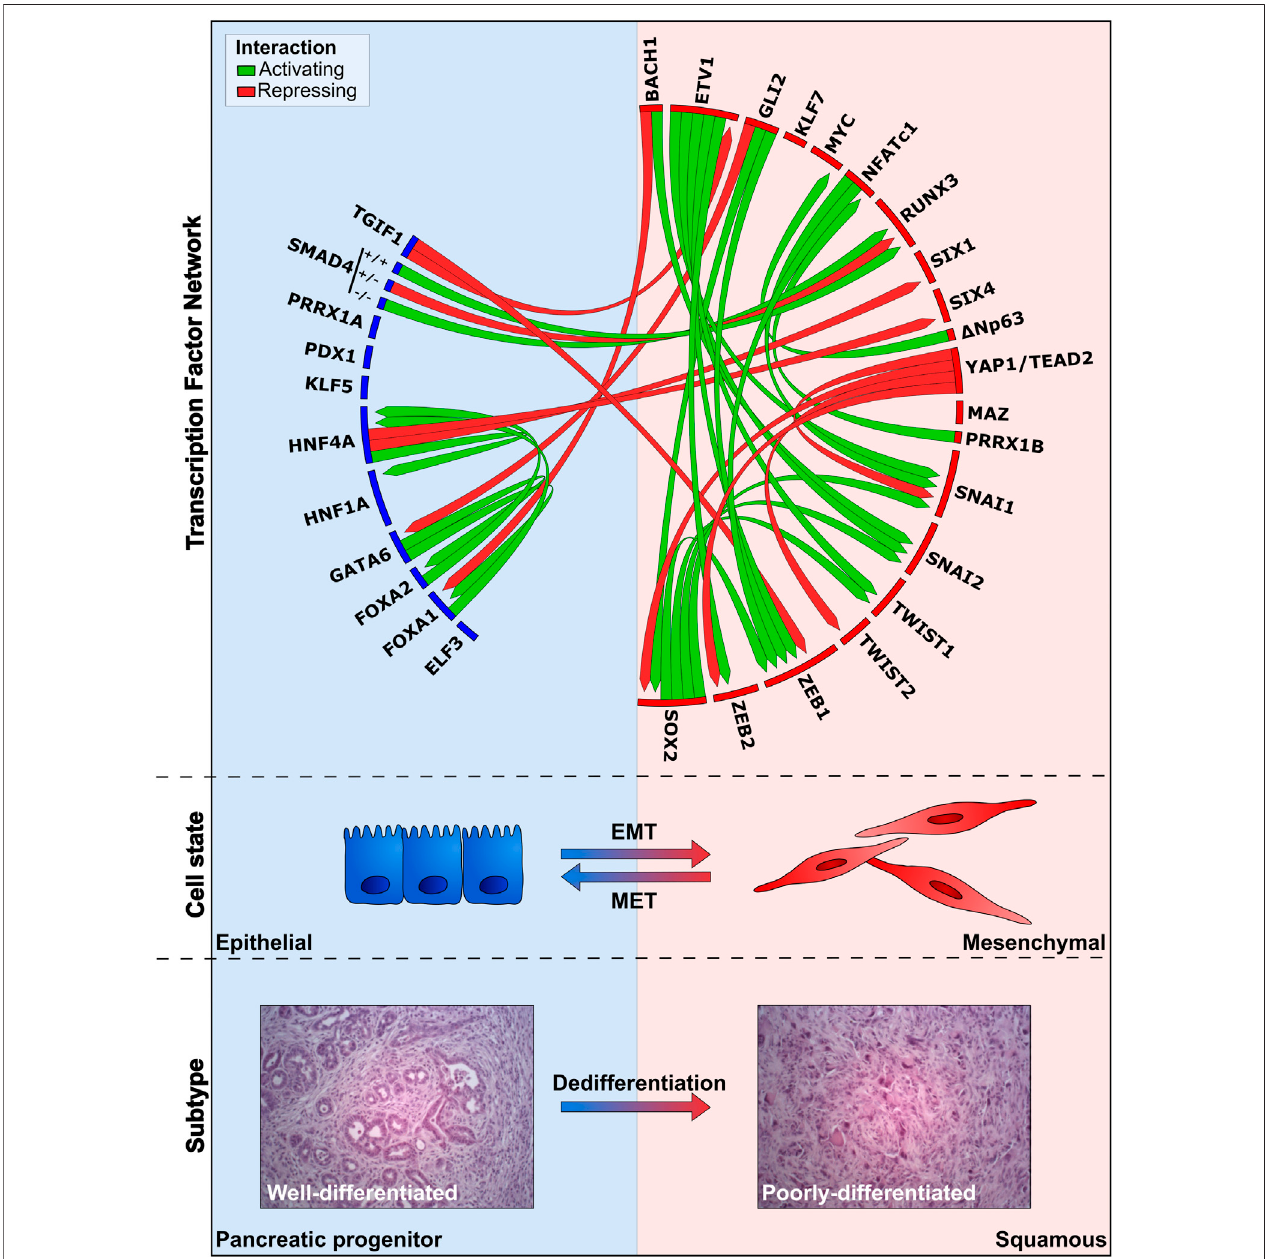
FIGURE 3 | Overview of TF networks active during PaCa progression, EMT, and metastasis. The deregulation directly or indirectly affects the expression of other TFs, therebypromotingorinhibiting thedifferentiation/EMTstate.TFs depictedintheblue boxareassociatedwiththeepithelialcell-state/pancreatic progenitor subtype (E-PP),whereas thered boxshowsTFs linkedtothemesenchymal-state/squamoussubtype (M-S).LinksresultinginactivationandrepressionofTFsinthenetworkare indicated by green and red lines, respectively. Expression of E-PP TFs in the blue box promote the differentiated endoderm/epithelial identity, block dedifferentiation, and prevent activation of stemness/EMT/dedifferentiation TFs. Activation of M-S TFs is associated with a mesenchymal identity, promotes dedifferentiation and activation of EMT and stemness. TFs without connections in the network have been associated with speci fi c subtypes, but how they integrate into the network is poorly understood. H&E images depict well-differentiated and poorly-differentiated tumors, derived from KPC primary pancreatic tumors, re fl ecting E-PP and M-S phenotypes (adapted from Krebs et al. (2017)).